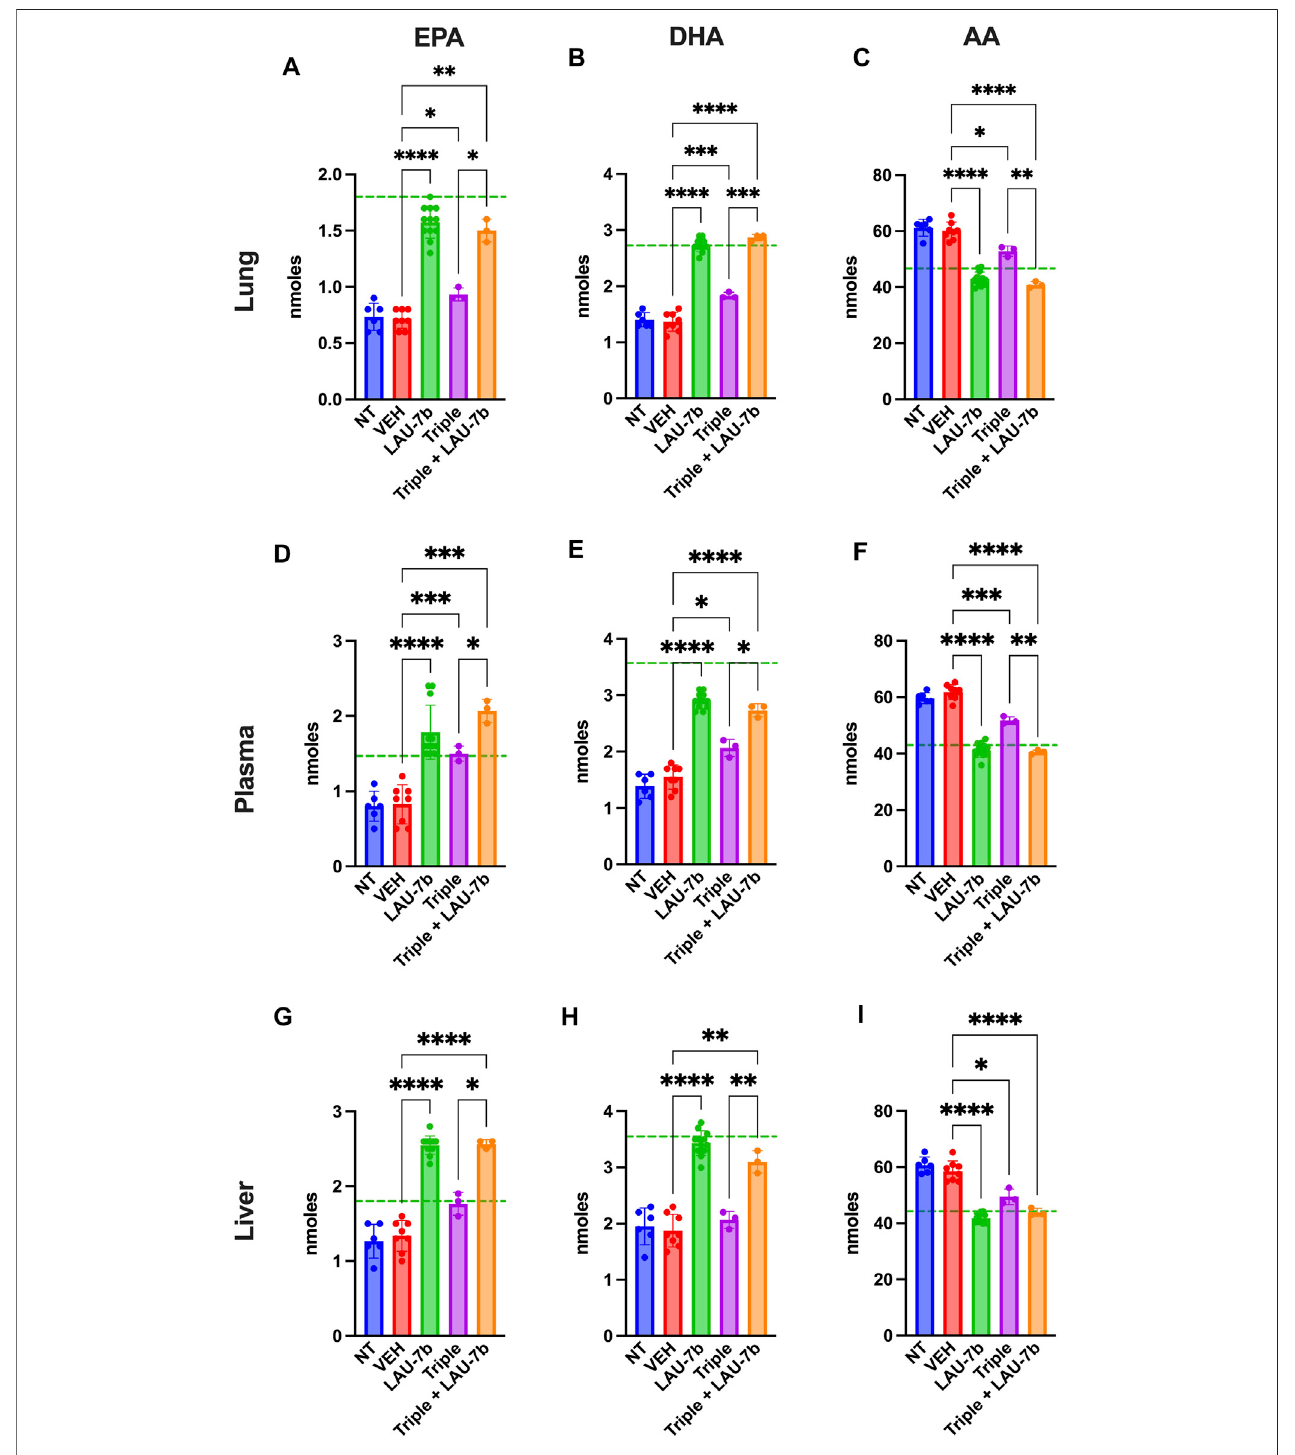
FIGURE5| Correctionoffattyacidsinthelungs, plasmaandliverofF508del/F508del(DD)miceisenhanced uponcombinationofTripletherapyandLAU-7b.Gas chromatography analysis of mouse lungs (A – C) , plasma (D – F) and liver (G – I) fatty acids. LAU-7b signi fi cantly increases omega-3 fatty acids, eicosapentaenoic acid (EPA)anddocosahexaenoicacid(DHA)inallthreesamplescomparablytomeanlevelsseeninWTmice(dottedgreenline).WhileTripletherapyaloneonlyshowslimited level of correction in lungs and plasma, the combination of the two signi fi cantly increases EPA and DHA in all samples when compared to vehicle (VEH) treated DD mice. Meanwhile, omega-6 fatty acid, arachidonic acid (AA) levels are signi fi cantly decreased in both LAU-7b and Triple therapy treated DD mice seen in all samples. Further improvement isseen upon combination of the two treatments ( n = 6, 8, 12, 3, 3, respectively for DD-NT, DD-VEH, DD-LAU-7b, DD-Triple, DD-Triple + LAU-7b). Brown-Forsythe and Welch One-Way ANOVA with Dunnett T3 correction, where * p < 0.05, ** p < 0.01, *** p < 0.001, **** p < 0.0001.